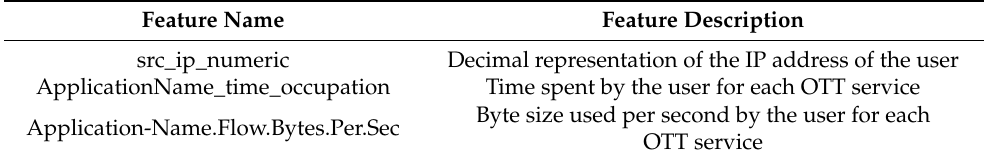
Table 2. Feature